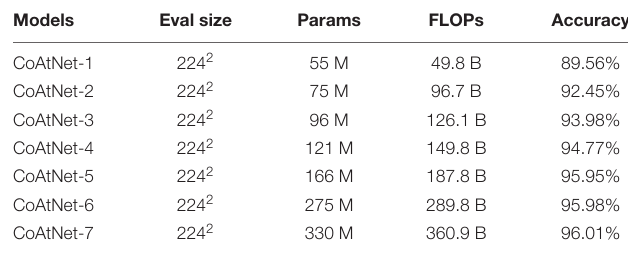
TABLE 6 | Experimental results for different backbone networks.